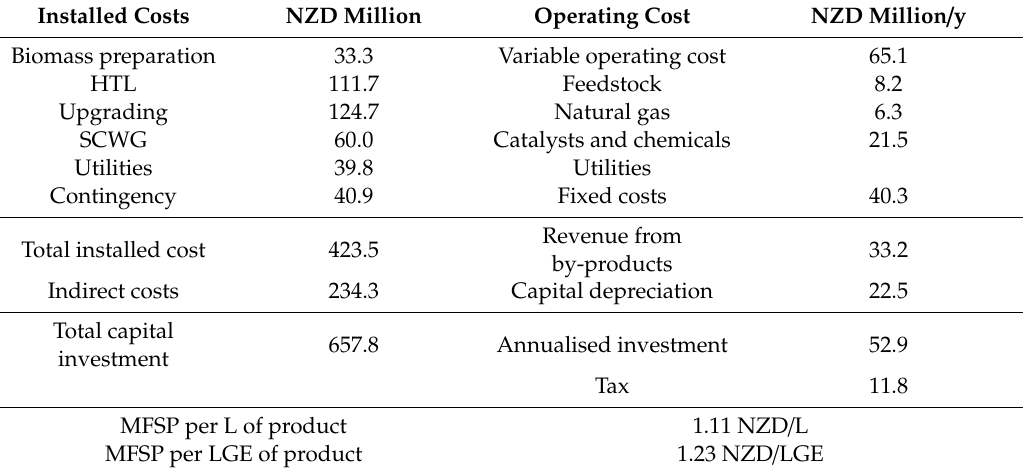
Table 4. Cost results for HTL system with 18% black